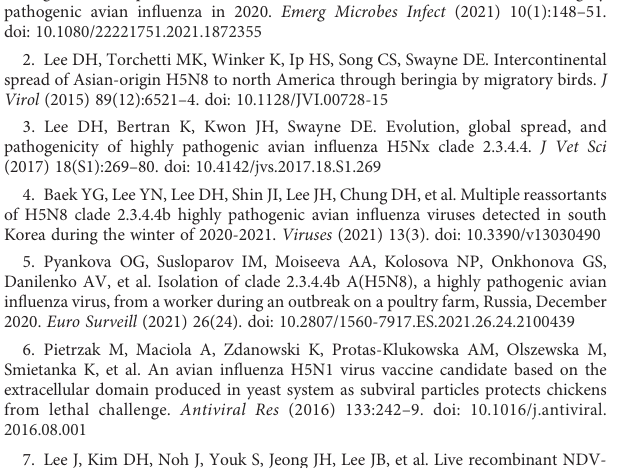
SUPPLEMENTARY FIGURE 1 Virus titer determination of each group in the trachea and Veri fi cation experiment of gene expression level in the Bursae of Fabricius post immunization. (A) Virus titer determination of each group in the trachea. Statistical analysis was analyzed by Student ’ s t-test. (ns, no signi fi cance. n=3 chickens for each group). The transcriptional levels of interleukin receptors (ILRs) (B) , C-C motif chemokine receptors (CCLRs) (C) , and interferon ligands (IFNLs) genes (D) in the Bursae of Fabricius of the immunized chickens were determined by RT-qPCR. Data were calculated based on the 2 − DD CT method, and relative mRNA expression was normalized to that of b -actin. The data in fi gures were obtained from three independent experiments and represent the averages ± SD. The signi fi cance of differences was determined by two-way analysis of variance (*, p < 0.05; **, p < 0.01; ***, p < 0.001; ****, p < 0.001 or ns, no signi fi